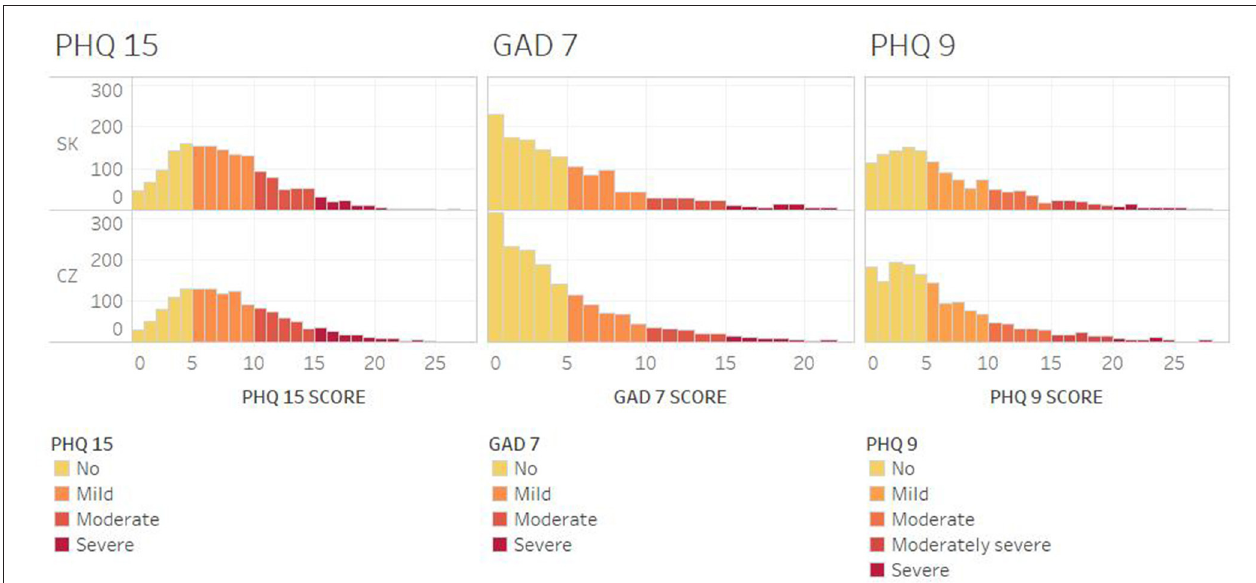
FIGURE 1 | Distribution of PHQ-15, GAD-7 and PHQ-9 scores in the Czech Republic and Slovakia.